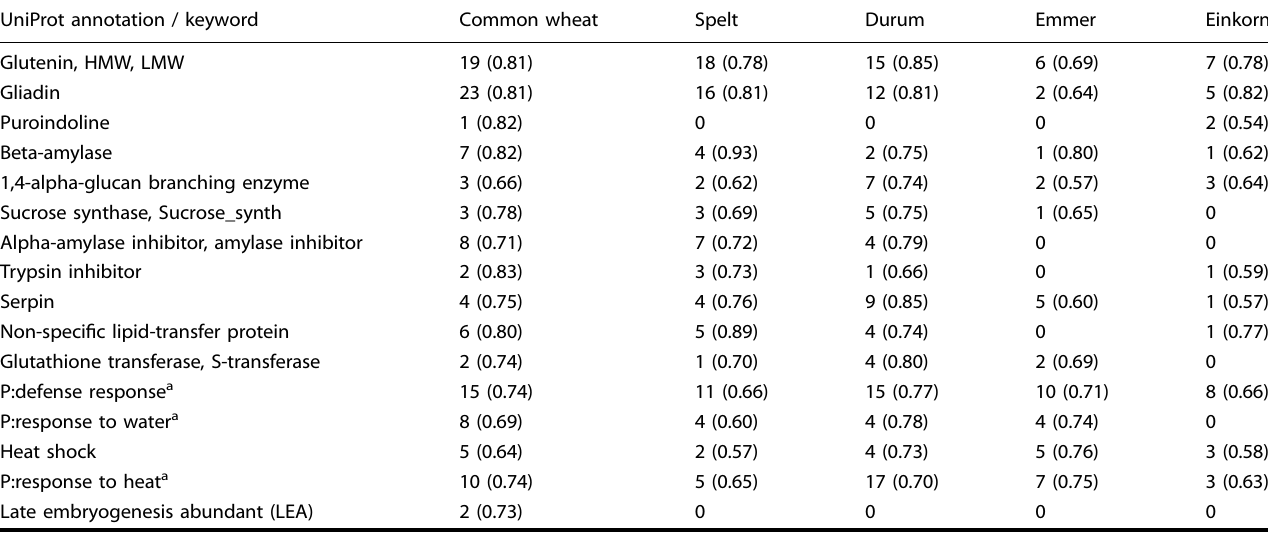
Table 1. Potentially interesting proteins for future research and breeding grouped into protein